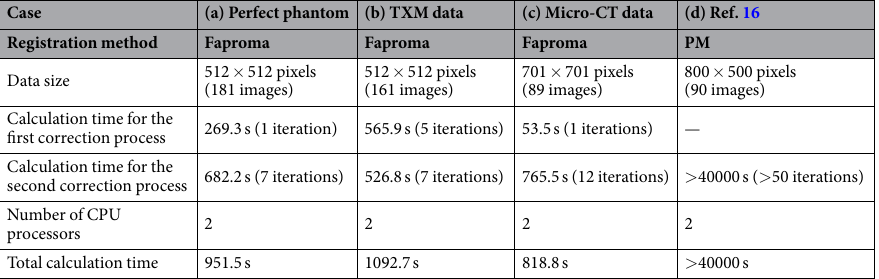
Table 1. Comparison of iteration times, calculation times, and hardware requirements for data obtained using various techniques and registration methods. The total calculation time in (b) is longer than in (a) because the signal-to-noise ratio of real cases will influence the total calculation time of Faproma. The calculation time for the first correction process is shorter in (c) than in (b) due to the quality of the background correction. The signal-to-noise ratio of the micro-CT data is better than for the TXM data. PM: traditional projection